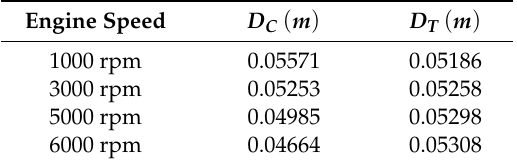
Table 3. Results of scaling for di ff erent engine speed